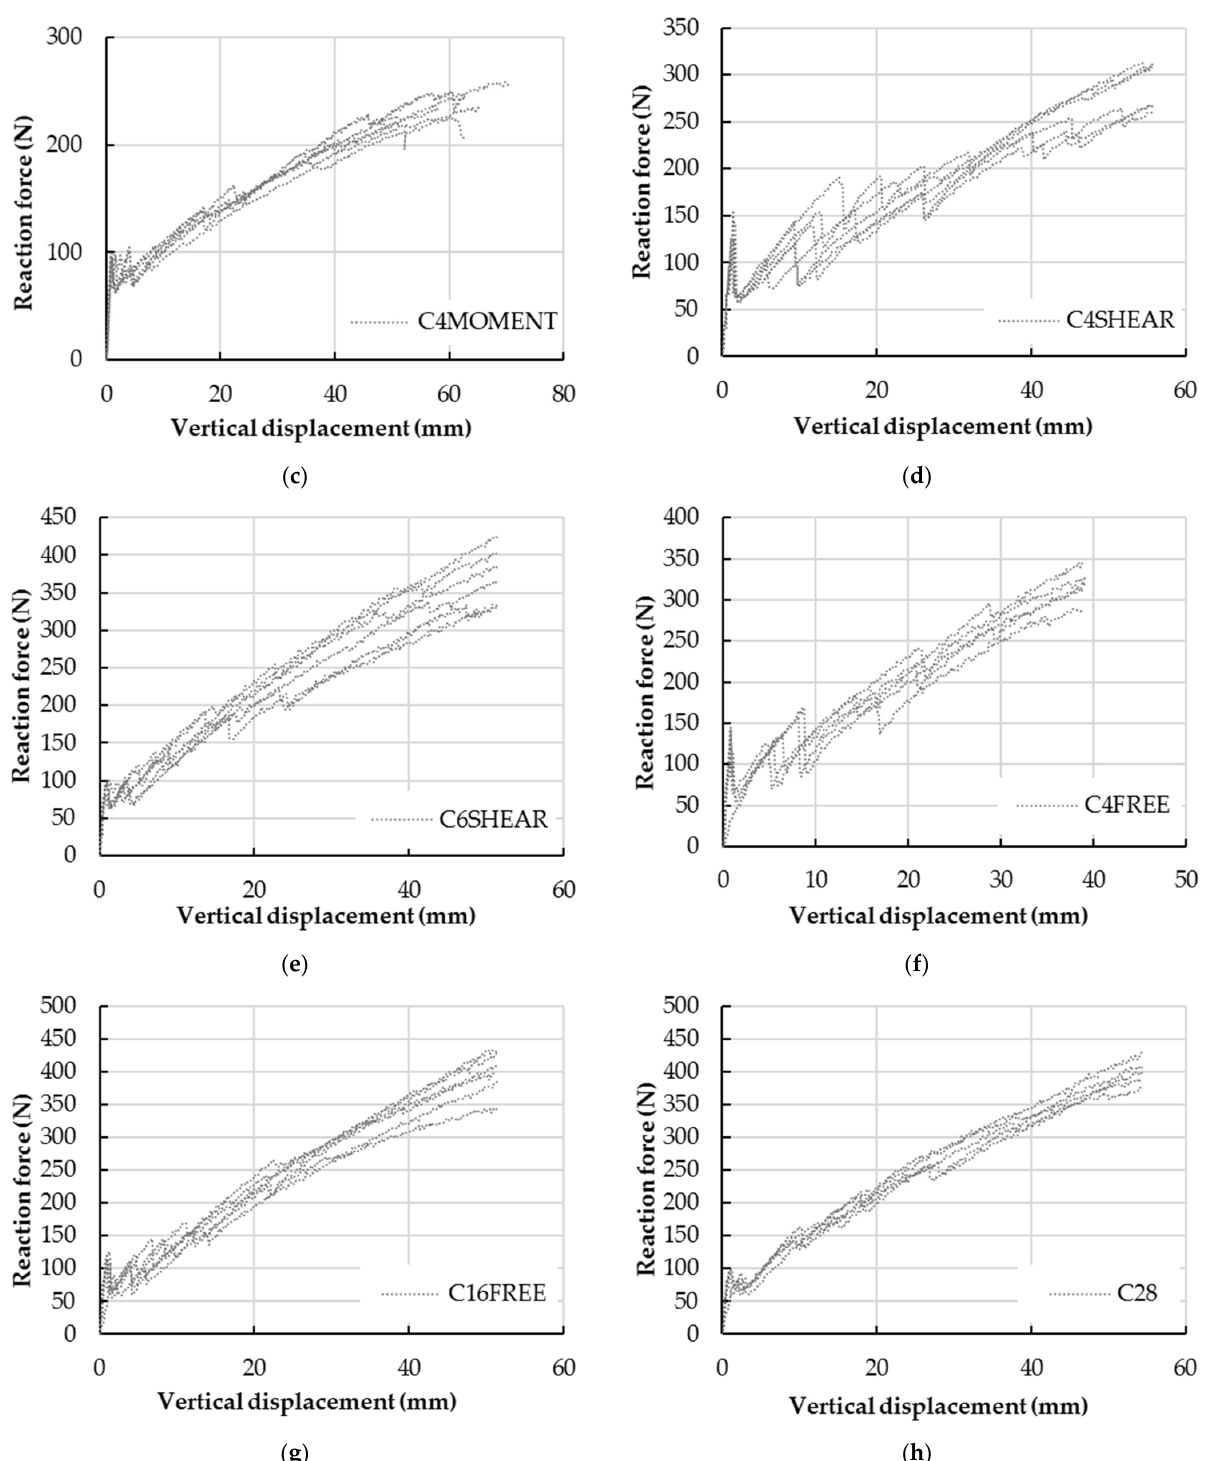
Figure 7. Reaction force (N)-displacement (mm) curves for all tested samples: ( a ) C0: samples without transversal connections; ( b ) KNIT: samples with knitted transversal connections; ( c ): C4MOMENT: samples with 4 transversal connections, placed in the moment zone; ( d ): C4SHEAR: samples with 4 transversal connections, placed in the shear zone; ( e ): C6SHEAR: samples with 6 transversal connections, placed in the shear zone; ( f ) C4FREE: samples with 4 transversal connections, placed in the free end zone; ( g ) C16FREE: samples with 16 transversal connections, placed in the free end zone; ( h ) C28: samples with 28 connections placed over the entire